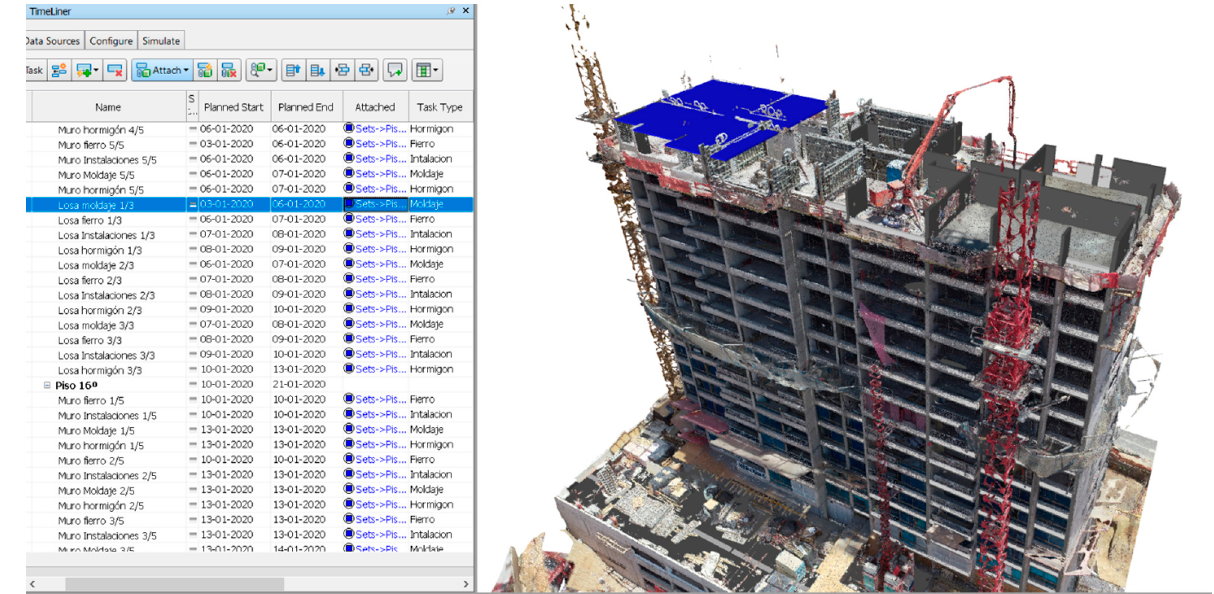
Figure 11. Visualization of the work schedule in the Naviswork Manage software.